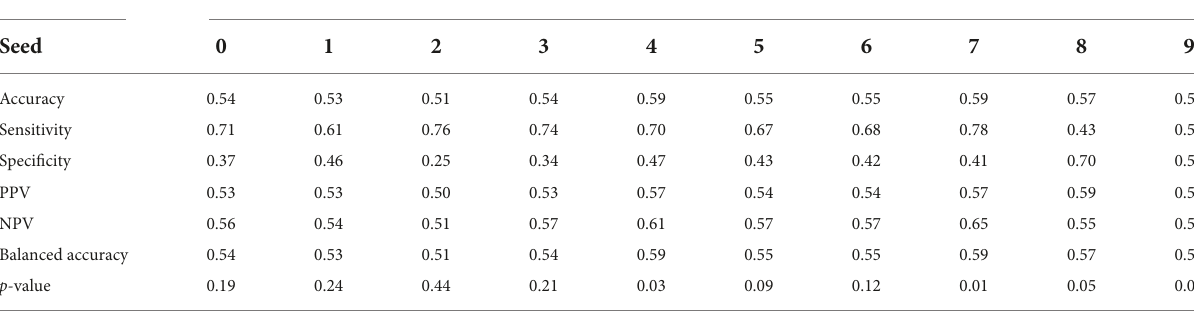
TABLE 1 Ensemble performance of models with a mean score as evaluation metric and the highest percentage of fold-out scores above 0.5 for fold